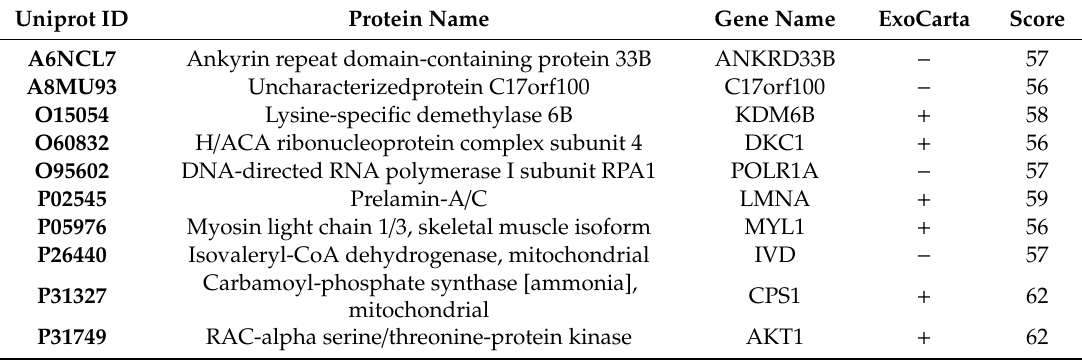
Table 6. Unique Exosomal Proteins Identified in Total Blood of